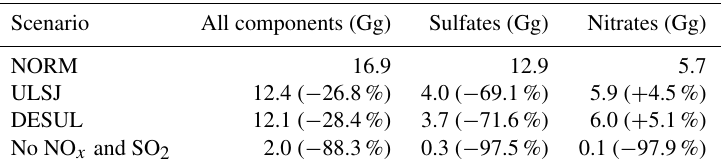
Figure 3. Impact of aviation emissions (FSC = 600ppm) on surface annual mean PM 2 . 5 concentrations. (a) absolute (NORM–NOAVI) and (b) percentage changes. Boxes show the European (20–40 ◦ E, 35–66 ◦ N) and North American (146–56 ◦ W, 29–72 ◦ N) regions. Table 3. Global aviation-induced aerosol mass burdens for different emission scenarios. Values in parentheses show percentage change relative to NORM